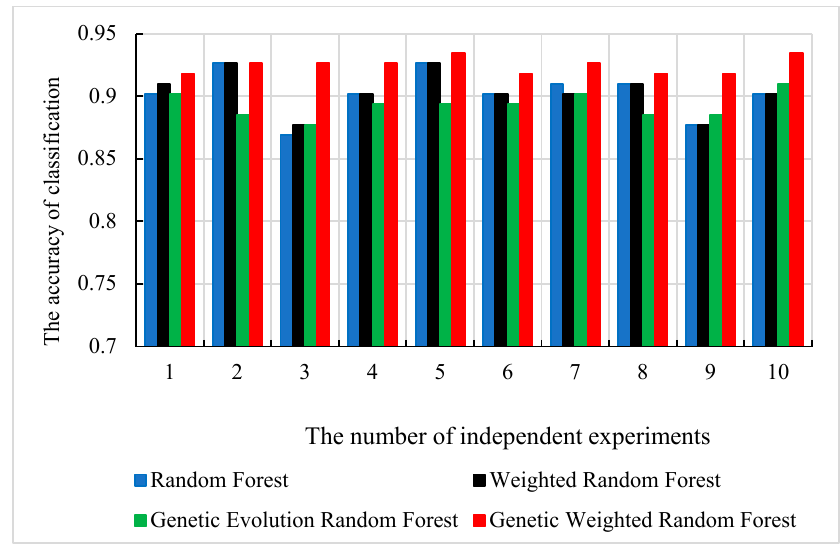
Figure 5. The ROC curves of the four models in (cid:2175) (cid:2204)(cid:2183)(cid:2194)(cid:2191)(cid:2186) .